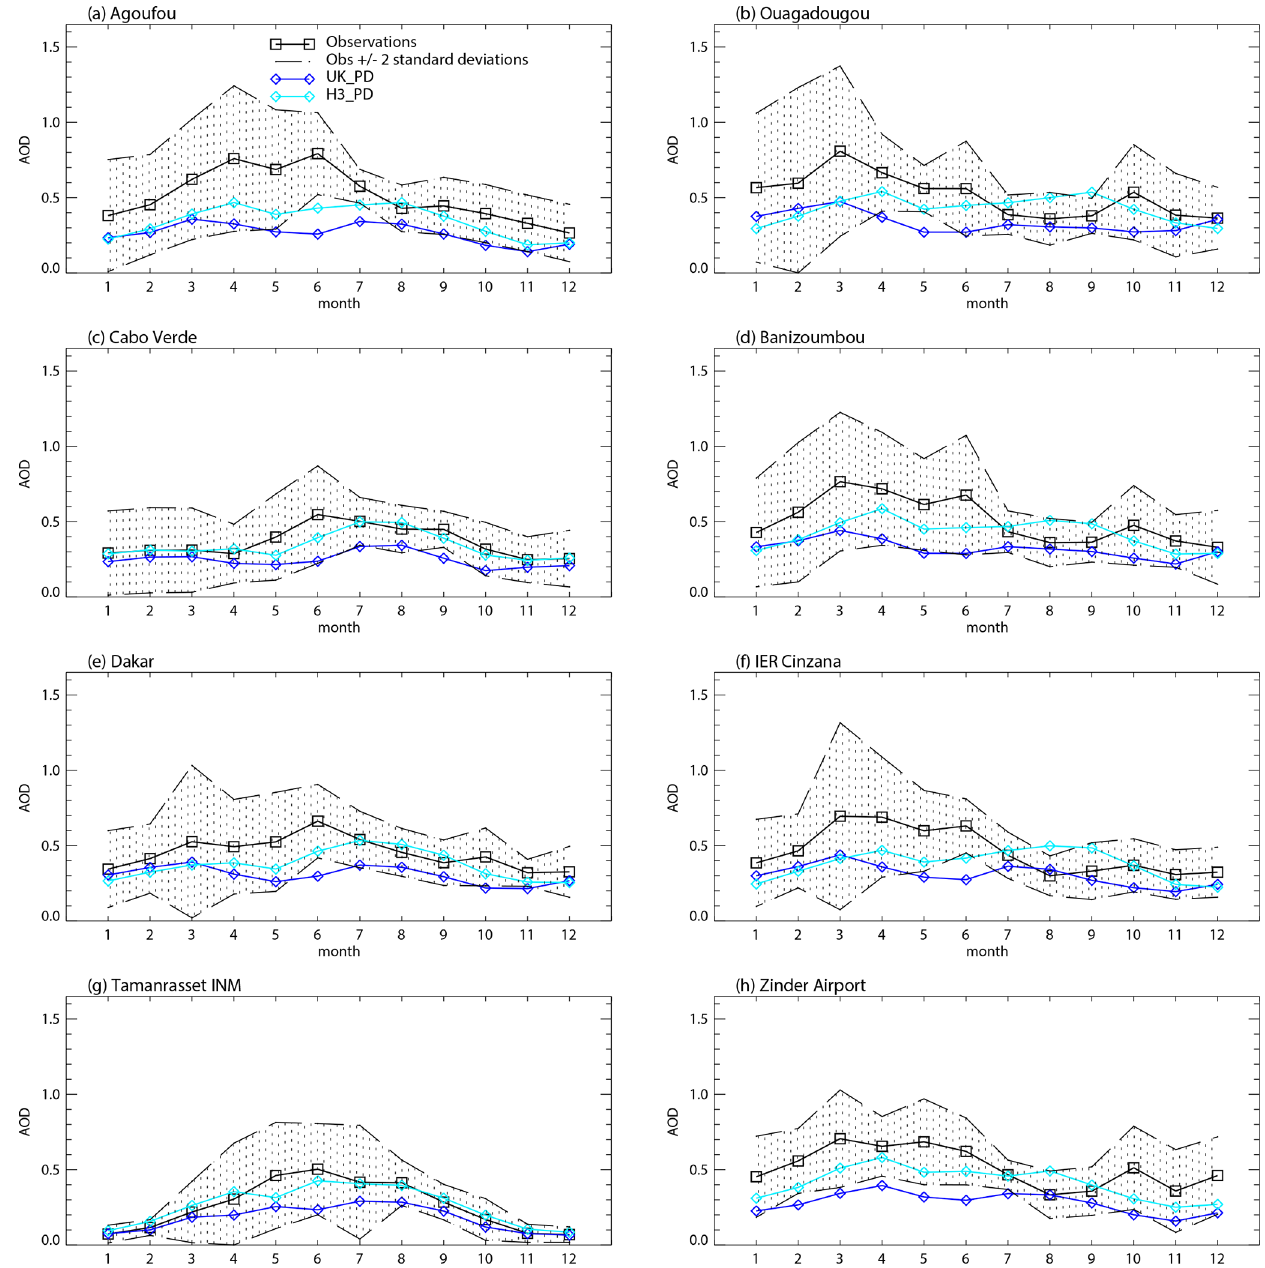
Figure 4. Annual cycle of AOD (440nm) at dust-dominated AERONET stations from UK_PD and H3_PD. Site locations are Agoufou (1.48 ◦ W, 15.35 ◦ N), Ouagadougou (1.40 ◦ W, 12.20 ◦ N), Cabo Verde (22.94 ◦ W, 16.73 ◦ N), Banizoumbou (2.66 ◦ E, 13.54 ◦ N), Dakar (19.96 ◦ W, 14.39 ◦ N), IER Cinzana (5.93 ◦ W, 13.28 ◦ N), Tamanrasset INM (5.53 ◦ E, 22.79 ◦ N) and Zinder Airport (8.99 ◦ E, 13.78 ◦